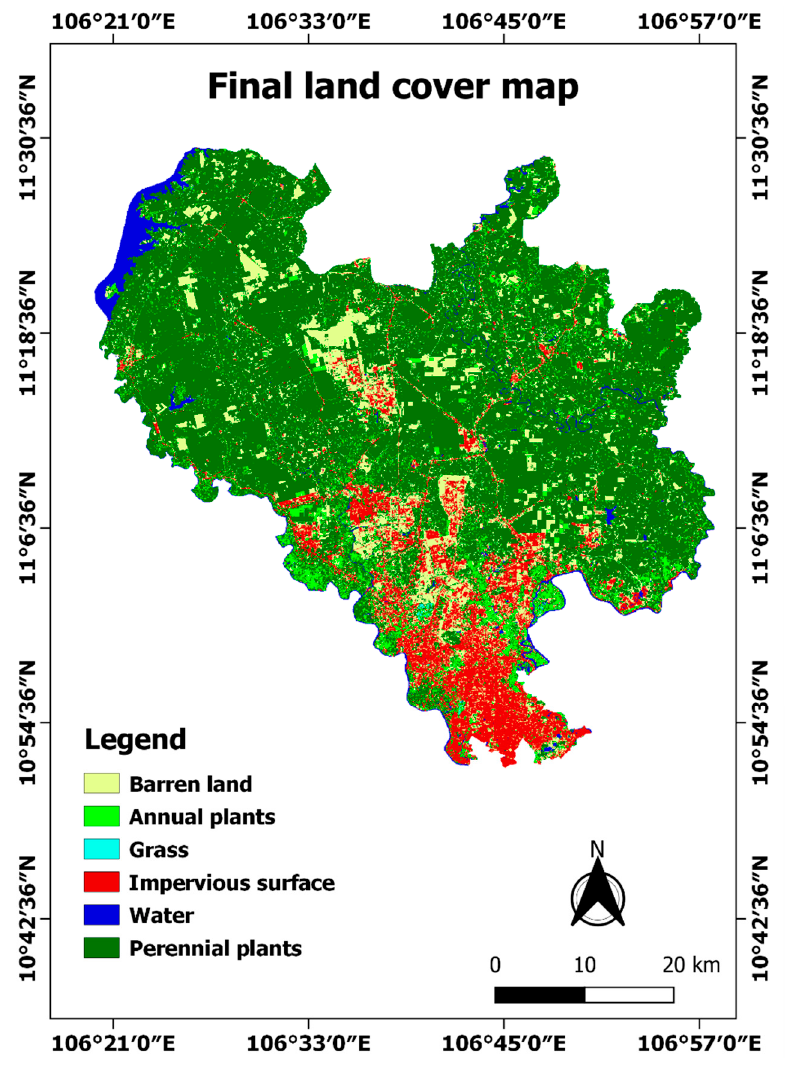
Figure 9. Final land cover map.